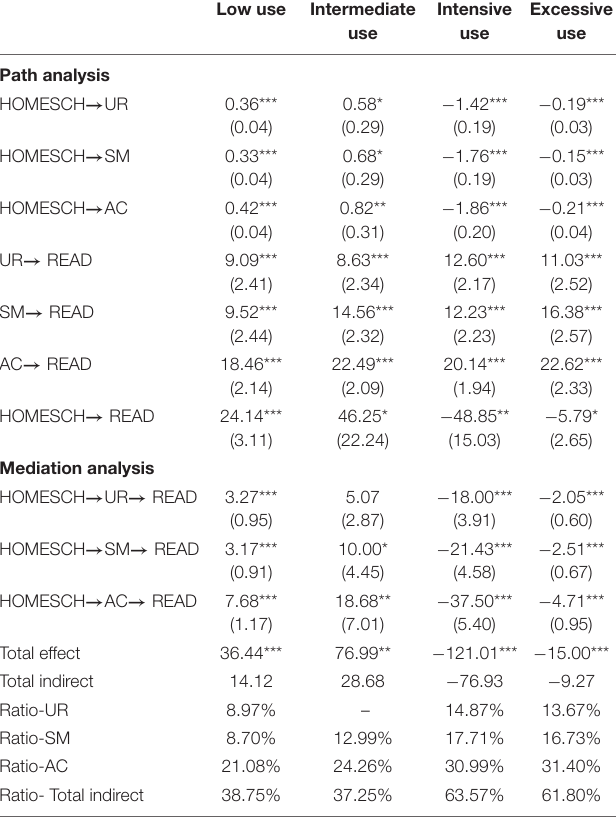
TABLE 7 | The moderated mediation analysis across HOMESCH